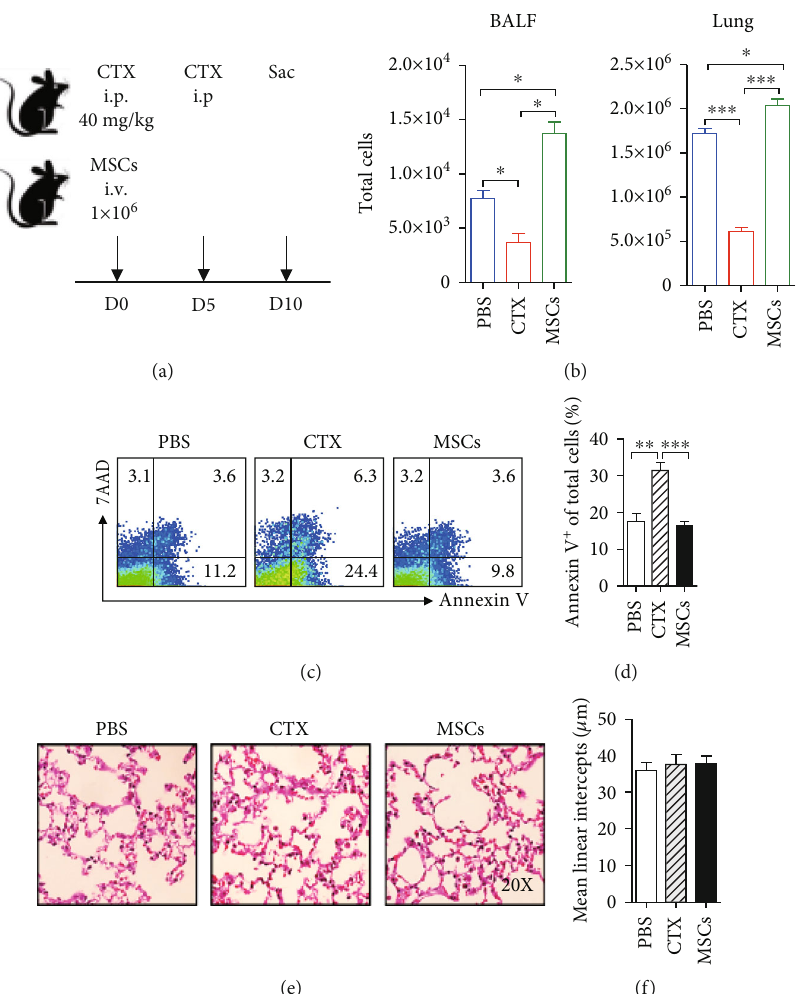
Figure 1: CTX reduced cells in the lung, whereas MSCs increased them. (a) B6 mice were treated with MSCs or CTX and sacri fi ced at indicated time. i.p.: intraperitoneal; i.v.: intravenous. (b) Cells from the BALF and lungs were isolated and counted. (c, d) Apoptotic status of lung cells was determined by FACS. (e) Lung pathology was examined by H&E staining. (f) Quantitative analyses of the pulmonary alveolar sizes, as measured by MLI. Data were expressed as the means ± SEM . n = 3 mice for each treatment group; ∗ p < 0 : 05 ; ∗∗ p < 0 : 01 ; ∗∗∗ p < 0 : 001 . This experiment is representative of three individual